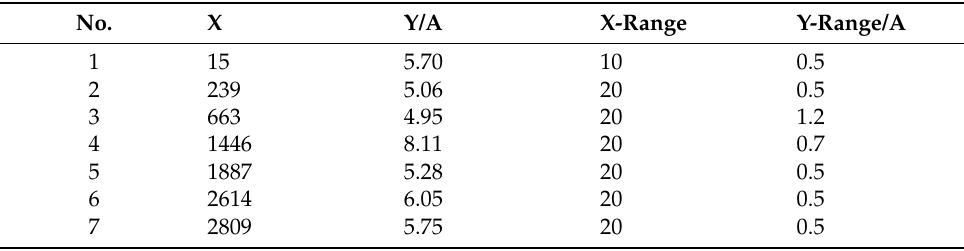
Table 3. Feature point